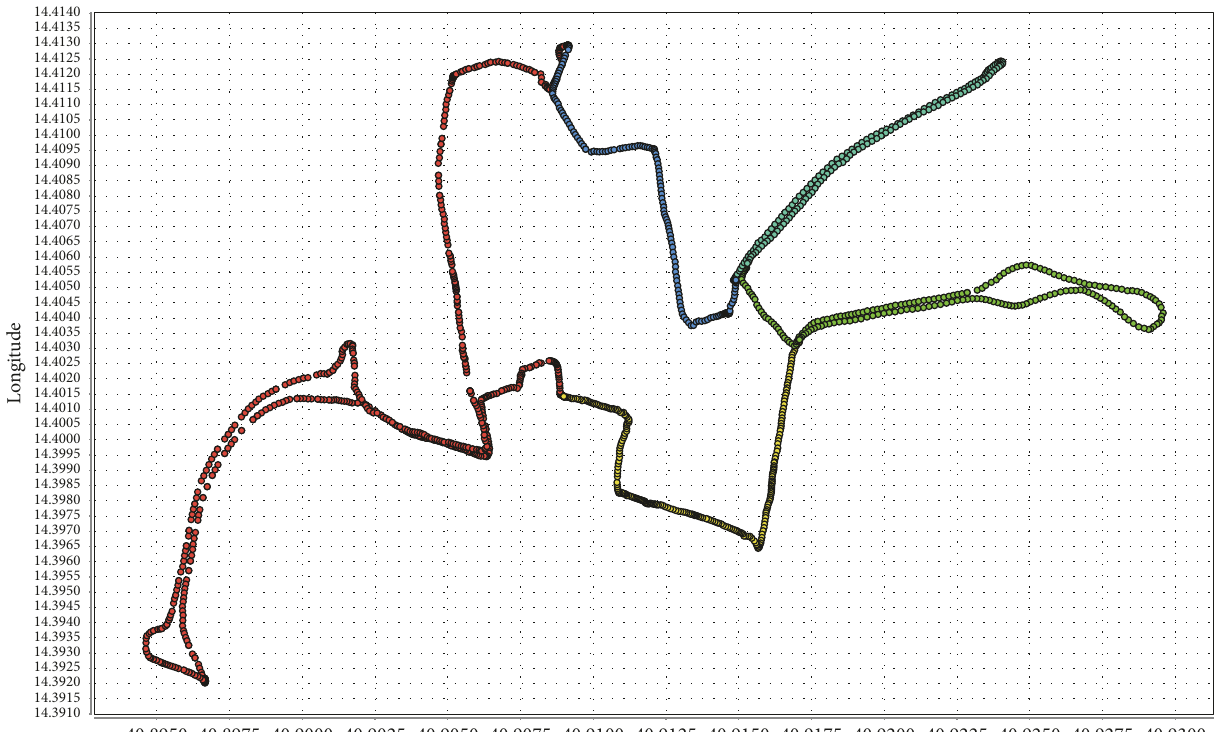
Figure 2: An overview of the paths under study: 30km in five paths of different kind in the Naples area.